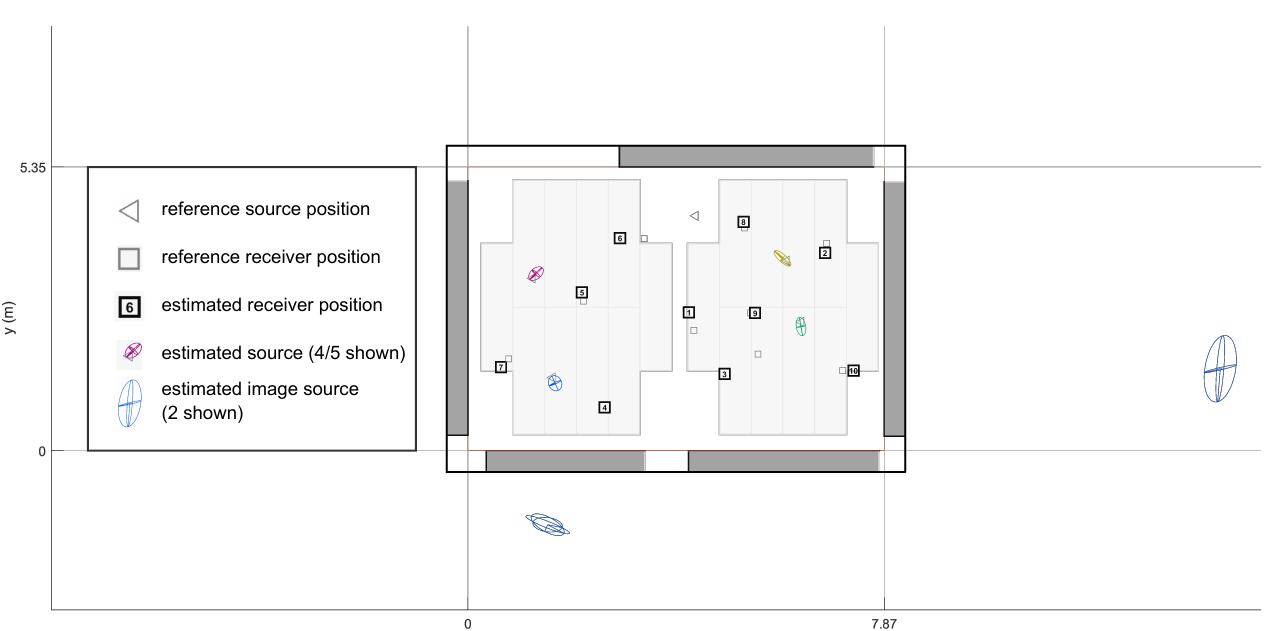
Figure 5. Legend for the result plots shown in Appendices A–C. In addition to the room image, there are 4 different markers to describe the algorithm output; (grey trianlge) reference source position; (grey rectangle) reference receiver position; (numbered rectangle) estimated receiver position; and (colored marker) estimated source and image source